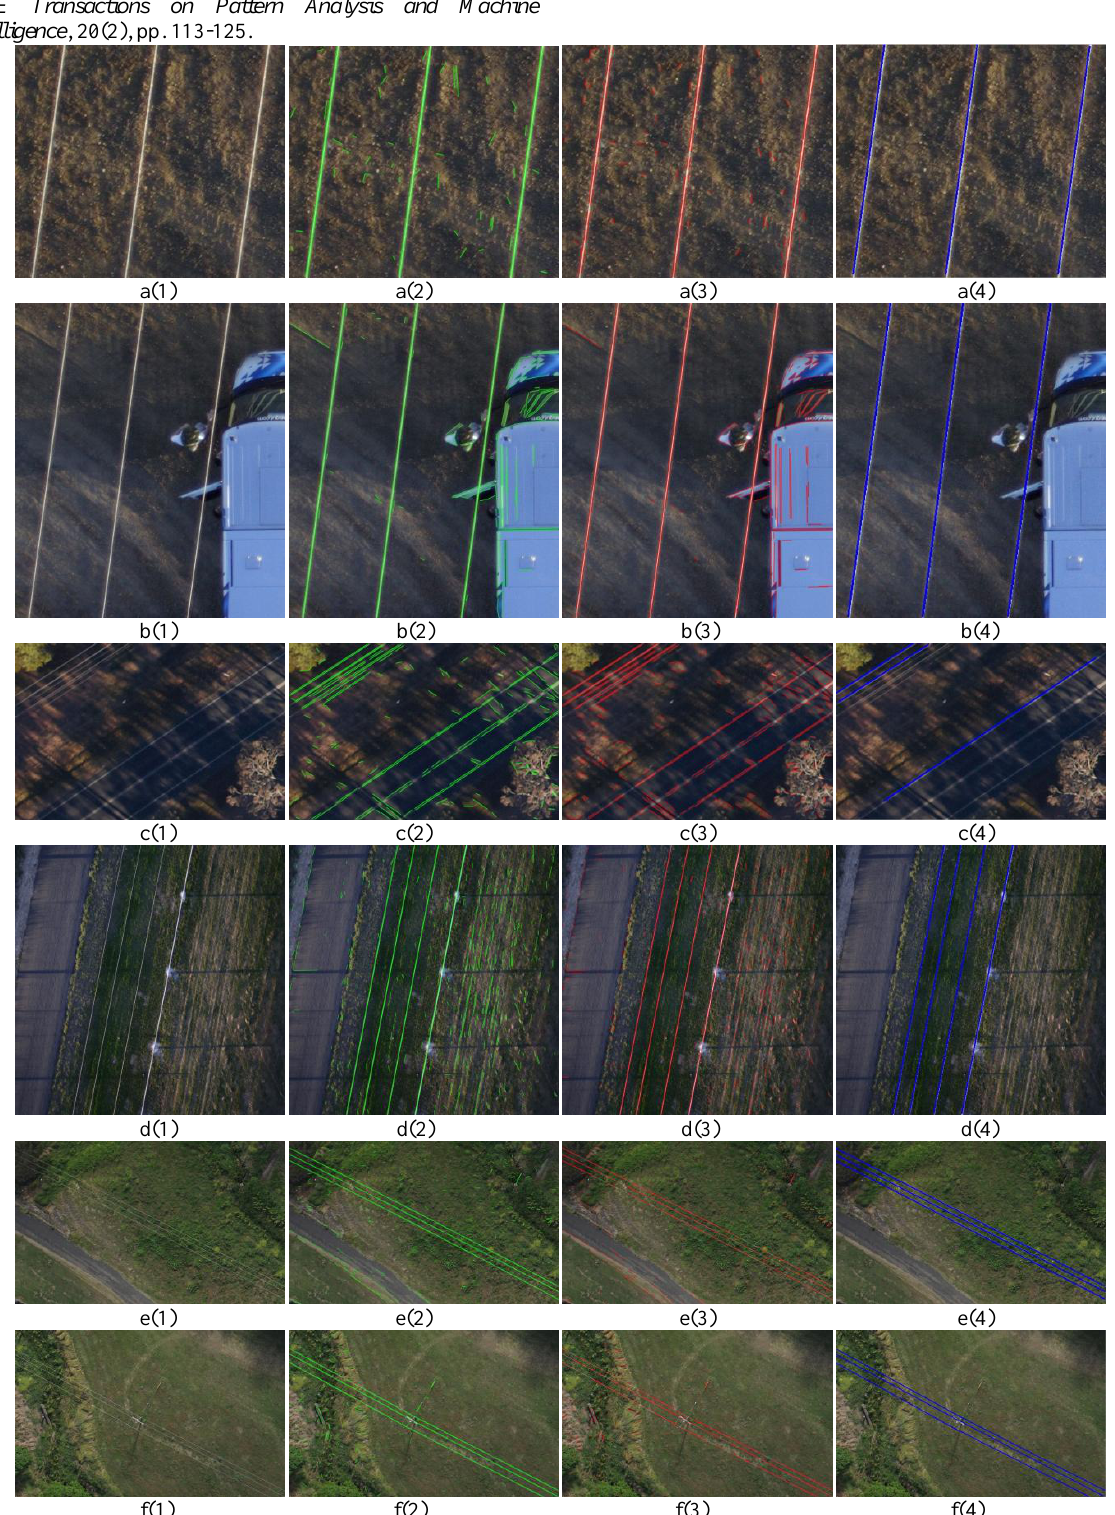
Figure 7. Results Comparison: each row represents a test set, column 1 are the original images, column 2-4 are the detection results by EDLines, LSD and our algorithm